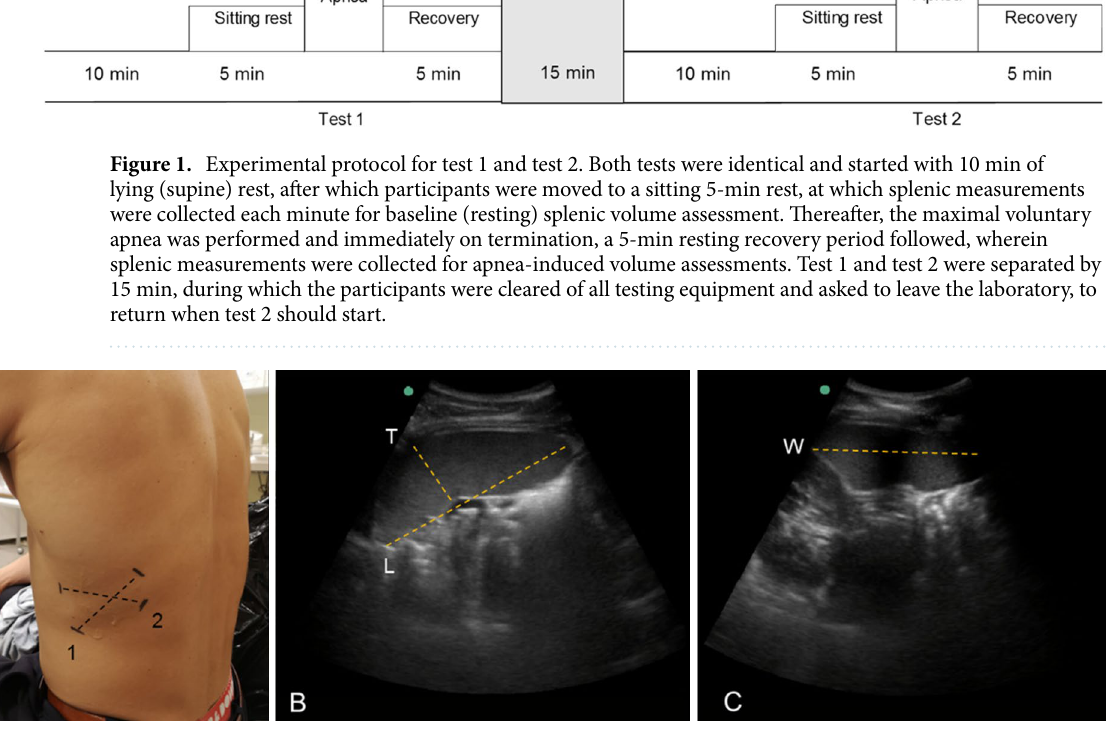
Figure 2. Determination of splenic size in resting state with ultrasonography, which was collected on the dorsal side of the body ( A ). Representative ultrasound images are shown to illustrate the measurement of maximal splenic length (L) and thickness (T) in the longitudinal plane ( B ) and line 1 in ( A ) and width (W) in the transverse plane ( C ) and line 2 in ( A